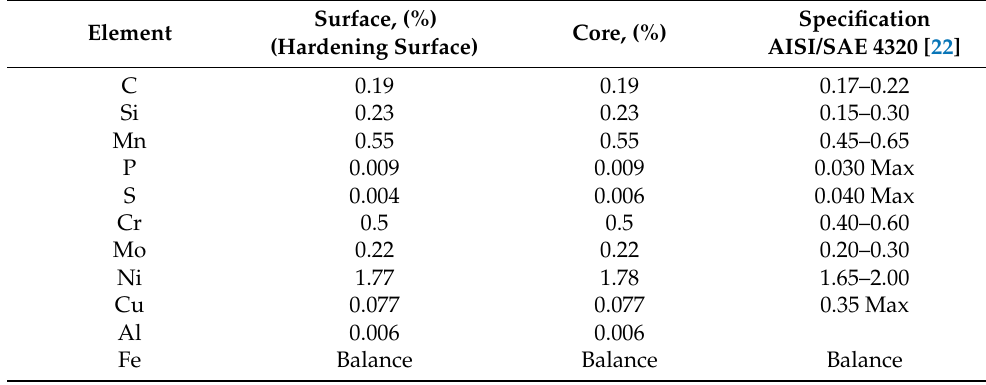
Table 2. Analysis of the shaft